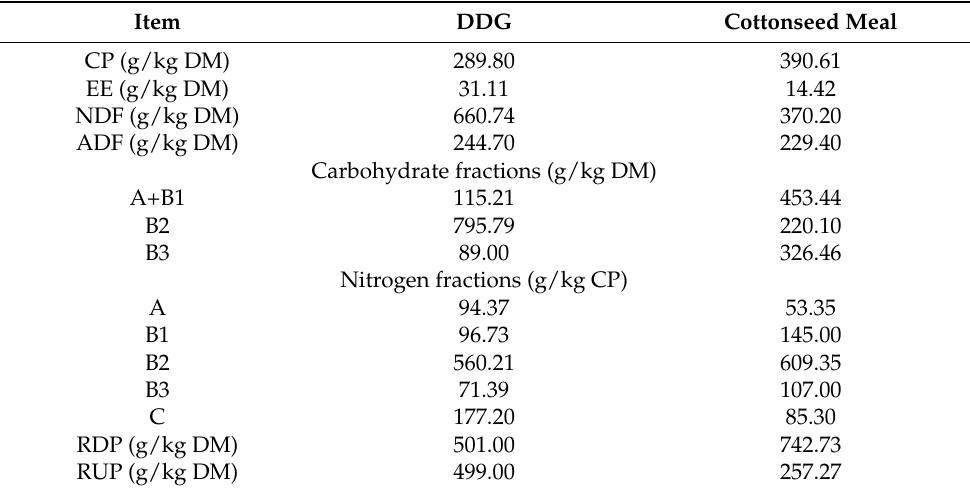
Table 1. Carbohydrate and protein fractions, and ruminal degradable (RDP) and undegradable (RUP) protein of corn